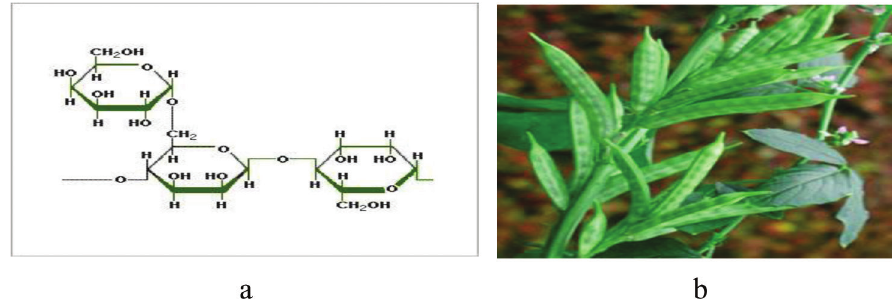
Figure 1: (a) Chemical structure of guar gum. (b) Guar gum